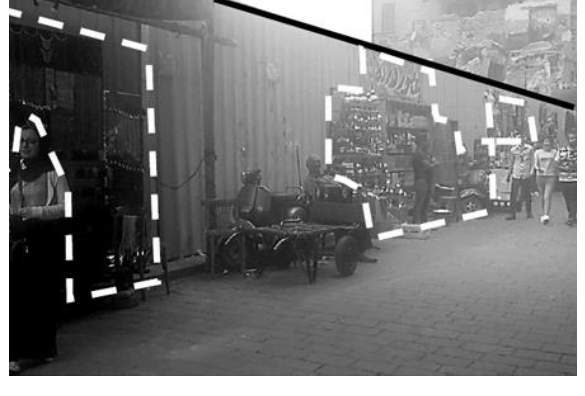
Figure 22. Territoriality.